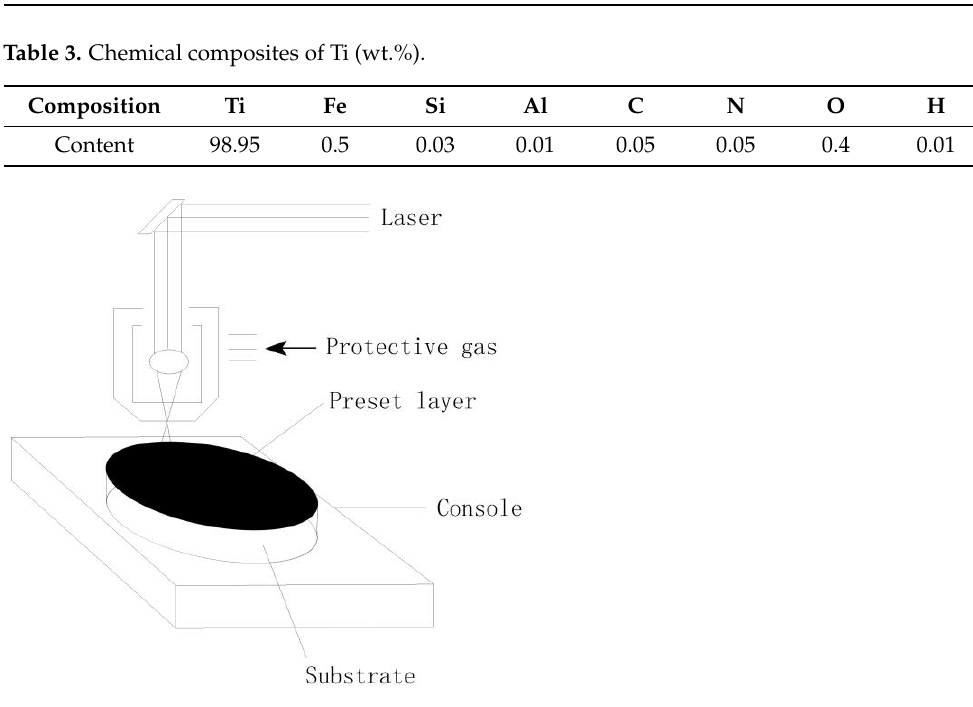
Figure 1. Schematic diagram of laser cladding test method.